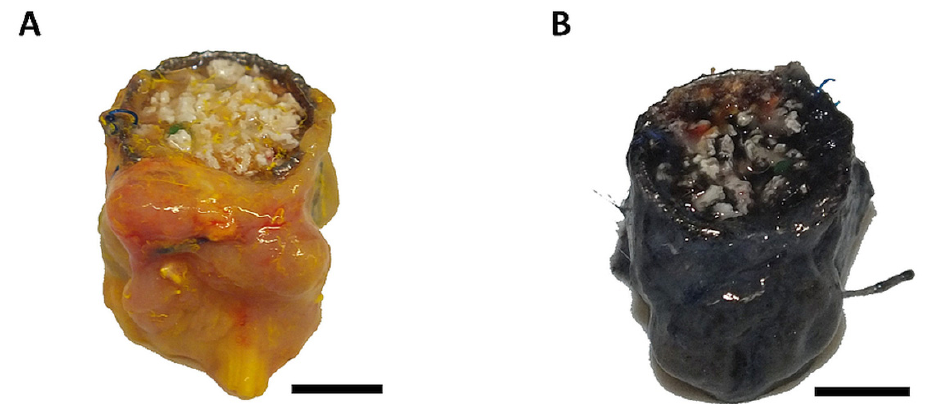
Figure 2. Macroscopic appearance. The explanted constructs appeared yellow-colored ( A ) if Microfil ® was used. In the case of India ink perfusion, the constructs appeared black ( B ).